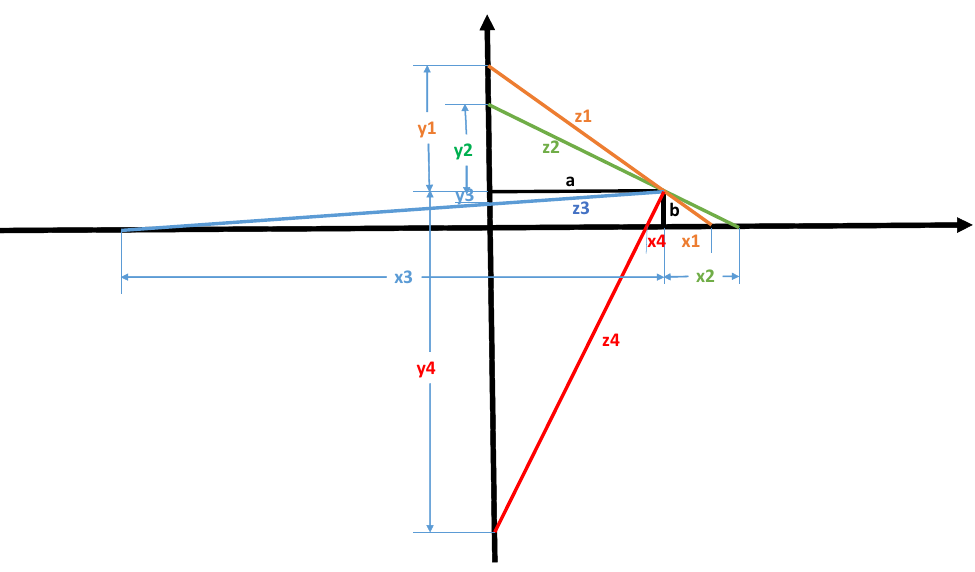
Figure 6. SPL: four integer solutions to the